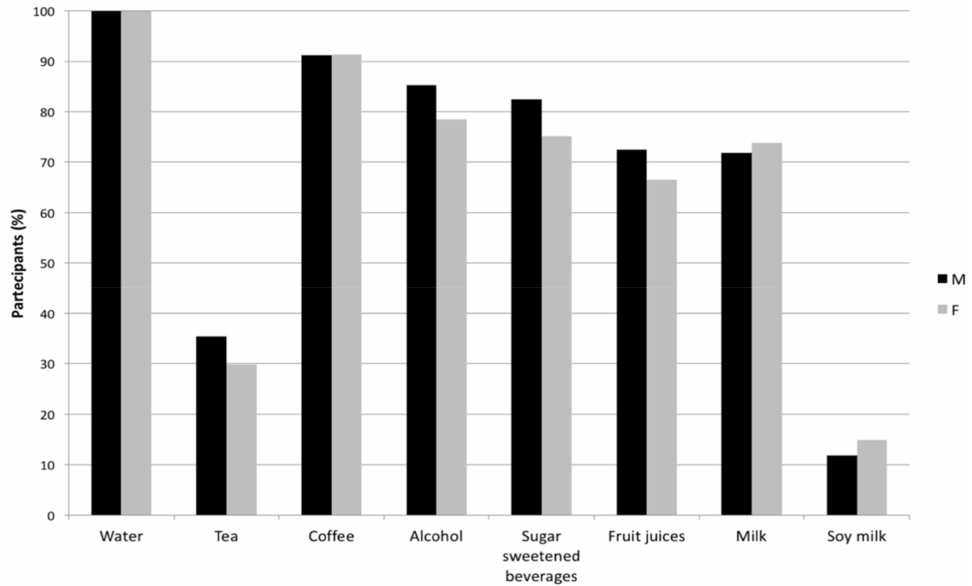
Figure 2. Prevalence of beverage consumption (% consumption by males and